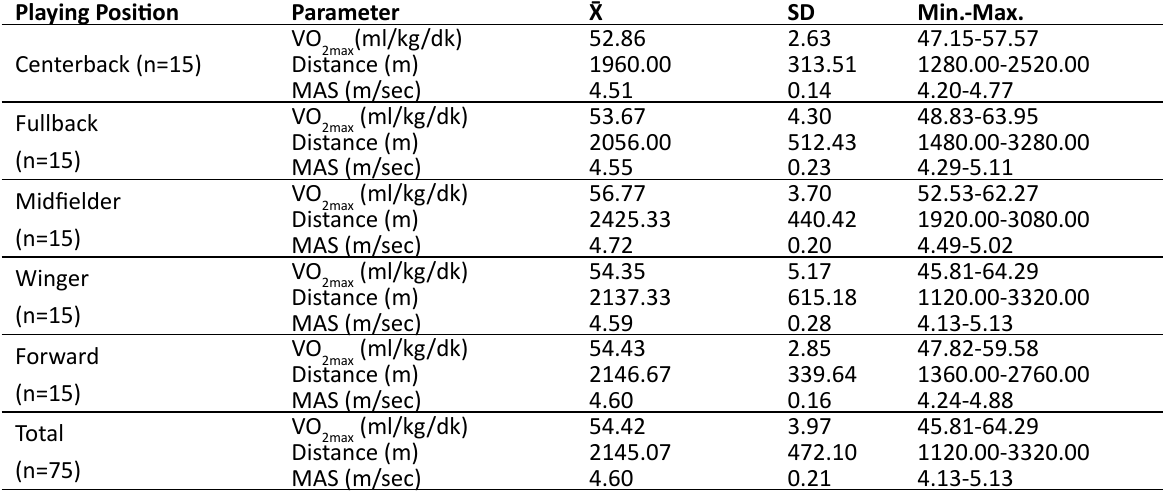
, covered distance and maximal aerobic speed values duringyyırt1 of 2max